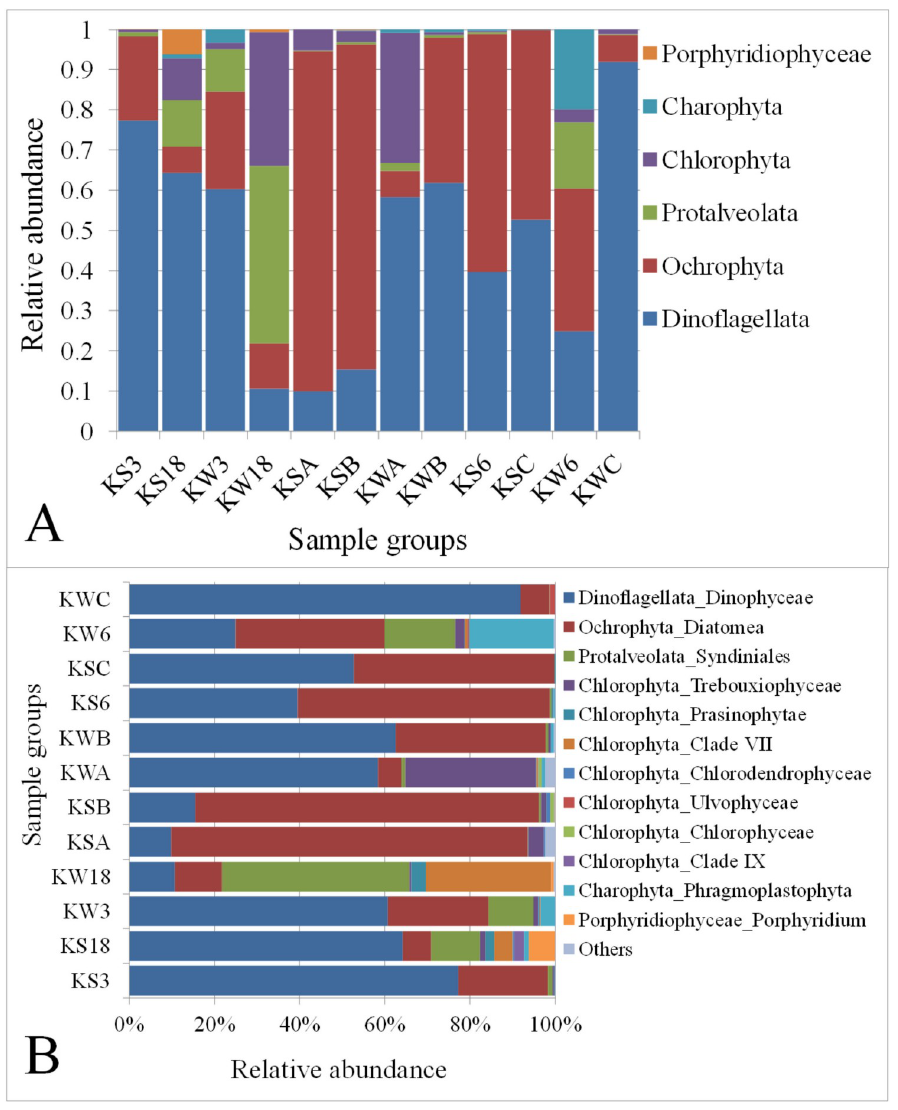
Fig 4. Relative abundance of (A) eukaryotic and (B) algal taxa across the sampling stations. KS: Samples collected during summer; KW: Samples collected during winter. ‘Others’ include taxa with < 0.1%